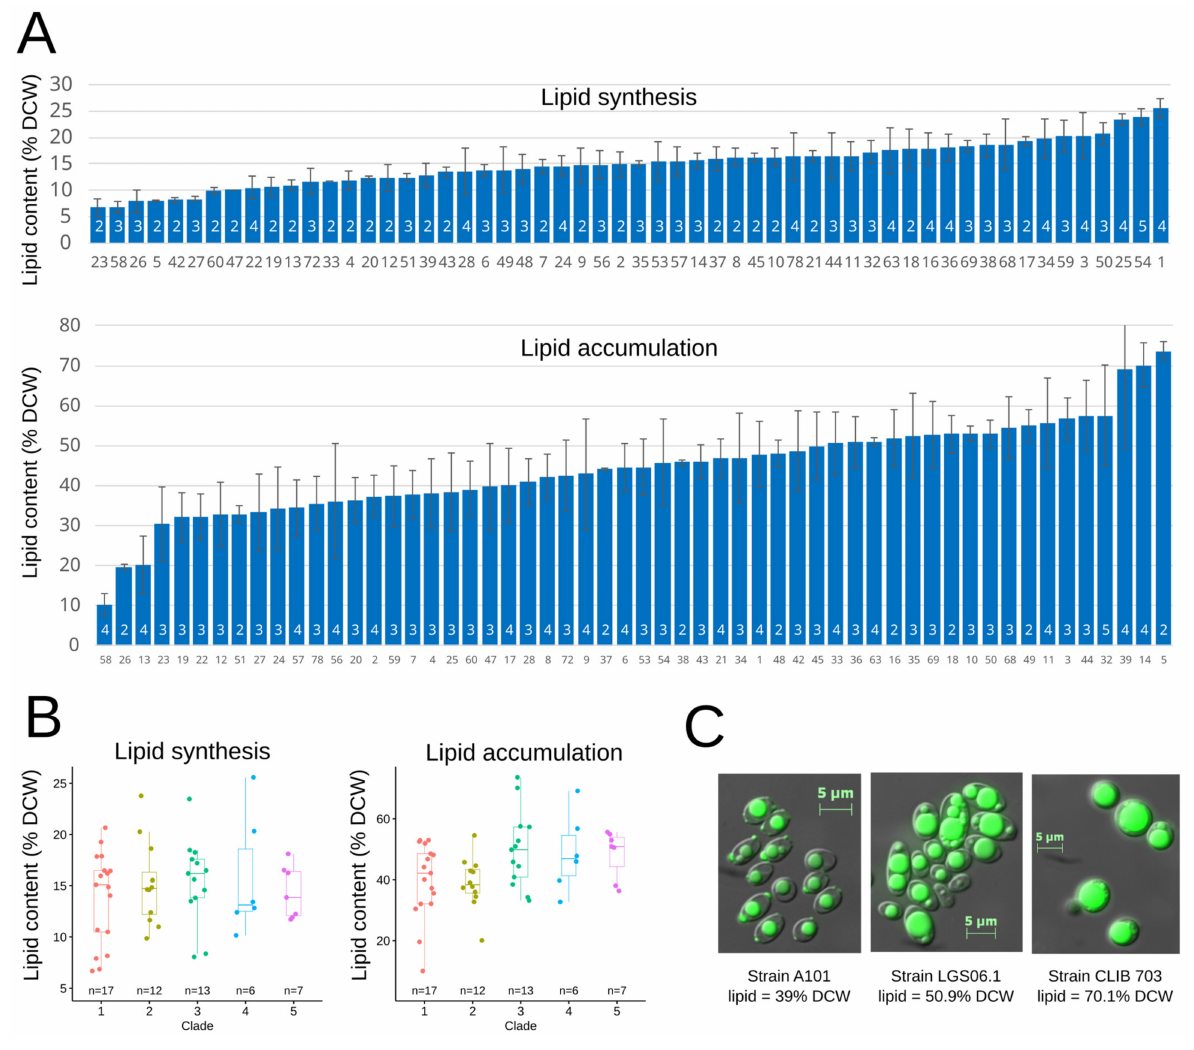
Figure 6. Lipid synthesis and accumulation were monitored as described in the materials and methods section. ( A ) lipid content for each strain of Y. lipolytica . Strain numbers in black correspond to the ID in Supplementary Table S1. The number of replicated measures is in white. ( B ) lipid content as a function of clade. ( C ) microscopic photography showing yeast cells with lipid bodies colored in green with BODIPY ®